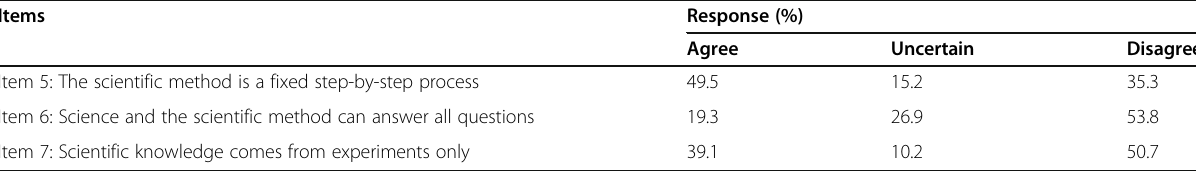
Table 4 Perceptions of the NOS: Scientific Method ( N = 225) Items Response (%)